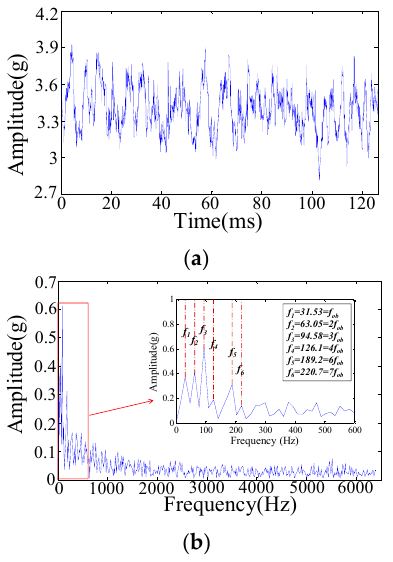
Figure 22. Time domain waveforms and spectrum of instantaneous amplitude. ( a ) Waveform of instantaneous amplitude; ( b ) Spectrum for instantaneous amplitude.